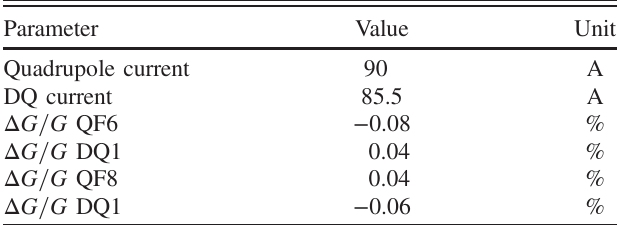
TABLE VIII. Simulated value of the integrated gradient error, for a DQ1 dipole-quadrupole installed at 90 mm from QF6 and QF8 high gradient